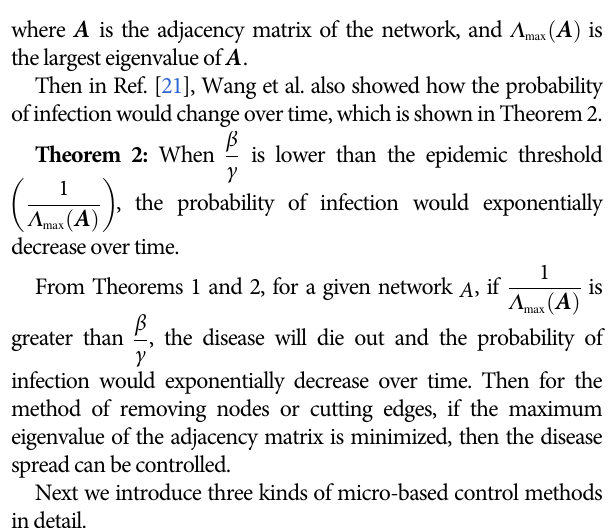
Figure 2a is the result with different ( , and the number of removed nodes is fixed as 100). The infection rate